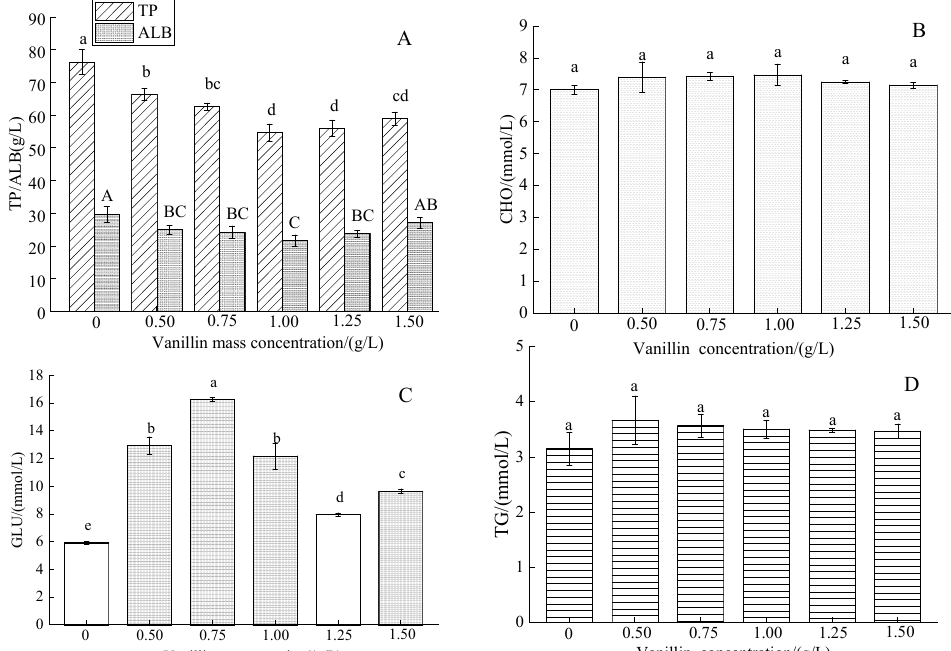
Figure 5. Effect of vanillin concentration on the blood serum concentrations of organic components in crucian carp: ( A ) total protein (TP) and albumin (ALB); ( B ) cholesterol (CHO); ( C ) glucose (GLU); and ( D ) triglycerides (TG). Different letters above the columns indicate a significant difference ( p < 0.05); the same letter indicates no significant difference ( p > 0.05).